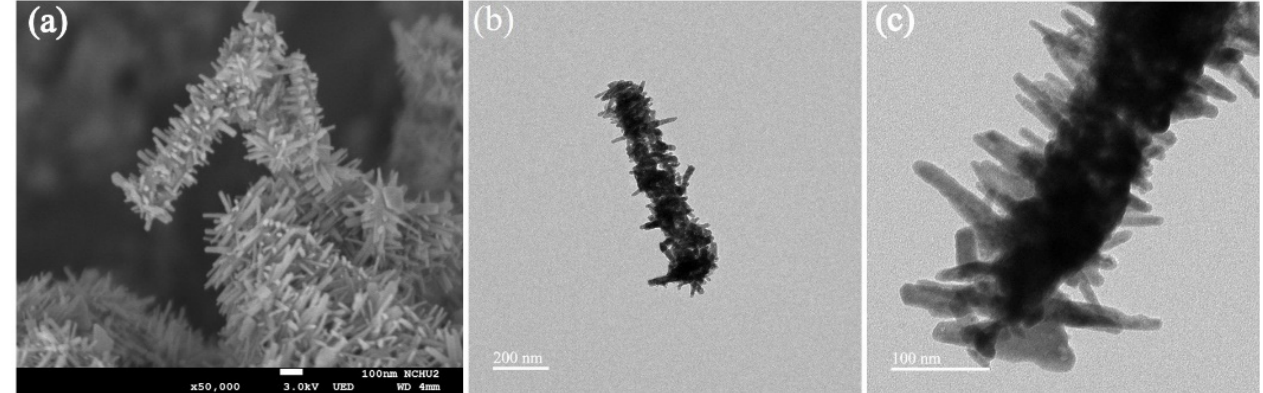
Figure 1. ( a ) FESEM, and ( b , c ) FETEM, images of Ni–Co–Te nanocomposites. The structure and phase composition of Ni–Co–Te nanocomposites were charac- terized by XRD pattern and compared with the standard patterns of CoNiTe 2 (JCPDS No. 65-8961) [32], as shown in Figure 2. The XRD pattern showed five distinct diffraction peaks located at 2 θ about 31.1 ◦ , 42.8 ◦ , 46.0 ◦ , 56.5 ◦ , and 58.2 ◦ , which conformed to the (101), (102), (110), (201) and (103) lattice planes of CoNiTe 2 . The surface elemental composition and valance states of Ni–Co–Te nanocomposites were characterized by XPS, as shown in Figure 3. The full scan XPS survey spectrum of the Ni–Co–Te nanocomposites (Figure 3a) confirmed the existence of Ni 2p, Co 2p, and Te 3d elements in the Ni–Co–Te nanocompos- ites. In order to further characterize the chemical states of these elements, the nanocom- posite was characterized in detail by high-resolution XPS spectra. The high-resolution XPS spectra of Ni 2p, Co 2p, and Te 3d of the Ni–Co–Te nanocomposites are shown in Fig- ure 3b–d, respectively. The Ni 2p XPS spectrum (Figure 3b) was divided into two spin–orbit doublets (873.2 eV for Ni 2p 1/2 and 855.4 eV for Ni 2p 3/2 ) with a spin–orbit splitting value of 17.8. To identify the specific Ni species, the Ni 2p 1/2 (Ni 2p 3/2 ) doublets were further de- convoluted into three peaks located at 872.2 eV (852.8 eV), 873.5 eV (855.6 eV), and 879.4 eV (861.2 eV), attributed to the Ni 2+ and Ni 3+ , and shake-up satellite (Sat.). This implied the coexistence of Ni 2+ and Ni 3+ states in the Ni–Co–Te nanocomposites [33]. Figure 3c shows that the Co 2p XPS spectrum included two spin–orbit-split doublets located at 796.3 eV in Co 2p 1/2 (780.6 eV in Co 2p 3/2 ) with a spin–orbit splitting value of 15.7 eV, accompanied by two shake-up satellites (Sat.) at 802.5 eV and 786.7 eV. The Co 2p 1/2 and Co 2p 3/2 peaks could be further deconvoluted into two overlapping peaks corresponding to Co 2+ and Co 3+ located at 797.8 eV (782.6 eV) and 796.2 eV (780.5 eV), revealing that Co 2+ and Co 3+ oxidation states coexisted in the Ni–Co–Te nanocomposites [34]. The Te 3d XPS spectrum in Figure 3d exhibited two spin–orbit peaks of Te 3d 3/2 and Te 3d 5/2 at 583.2 eV and 572.8 eV, and the spectra were accompanied by two strong shake-up satellites (Sat.) located at 586.4 eV and 576.0 eV. The obvious characteristic peaks of shake-up satellites implied Te 4+ in the Ni–Co–Te nanocomposites [35]. Therefore, the results of the above analyses demonstrate that Ni–Co–Te nanocomposites were successfully prepared and presented the best morphological and structural characteristics, which boosts their further promotion in practical applications for electrochemical